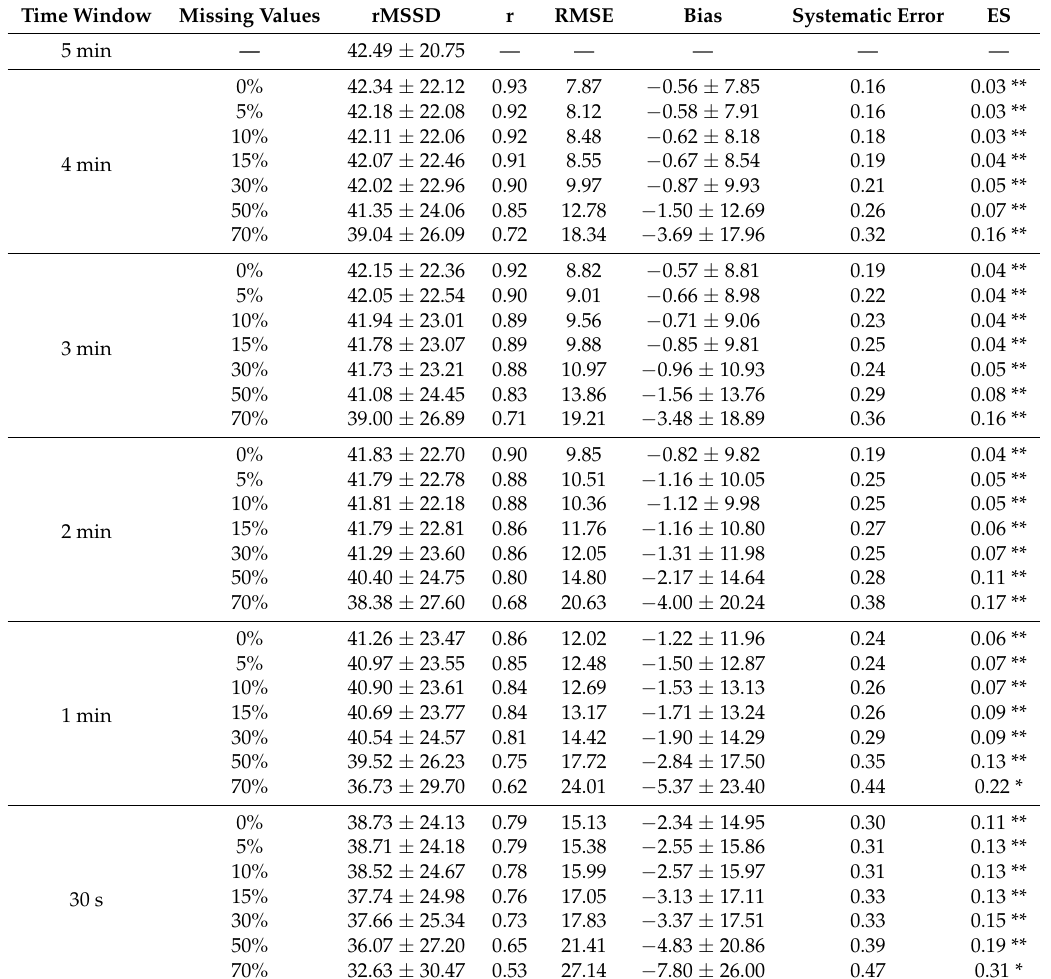
Table 2. Descriptive statistics (mean ± standard deviation) and statistical analysis of rMSSD for all of the time window and missing values. The statistical analysis is focused to compare 5 min HRV parameters to ultra-short ones. ** and * refer to the trivial and small ES of ultra-short HRV features compared to 5 min ones, respectively. r, RMSE, and ES refer to the correlation, the Root Mean Square Error and the effect size between the ‘gold standard’ and the ultra-short with and without missing values on rMSSD, respectively. Bias refers to mean ± standard deviation of the difference of ultra-short HRV parameters compared to ‘gold standard’ HRV parameters (i.e., 5 min time window), while systematic error is the Pearson’s correlation coefficient between means and differences between 5 min and ultra-short HRV